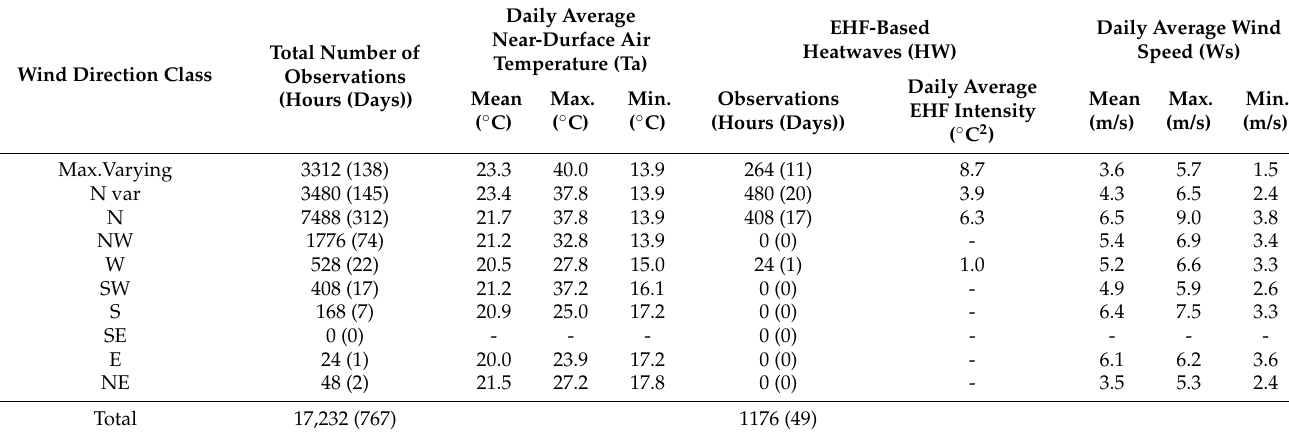
Table 4. Characterization of the temperature and wind observations at the airport reference station during prevalent summer and heatwave conditions